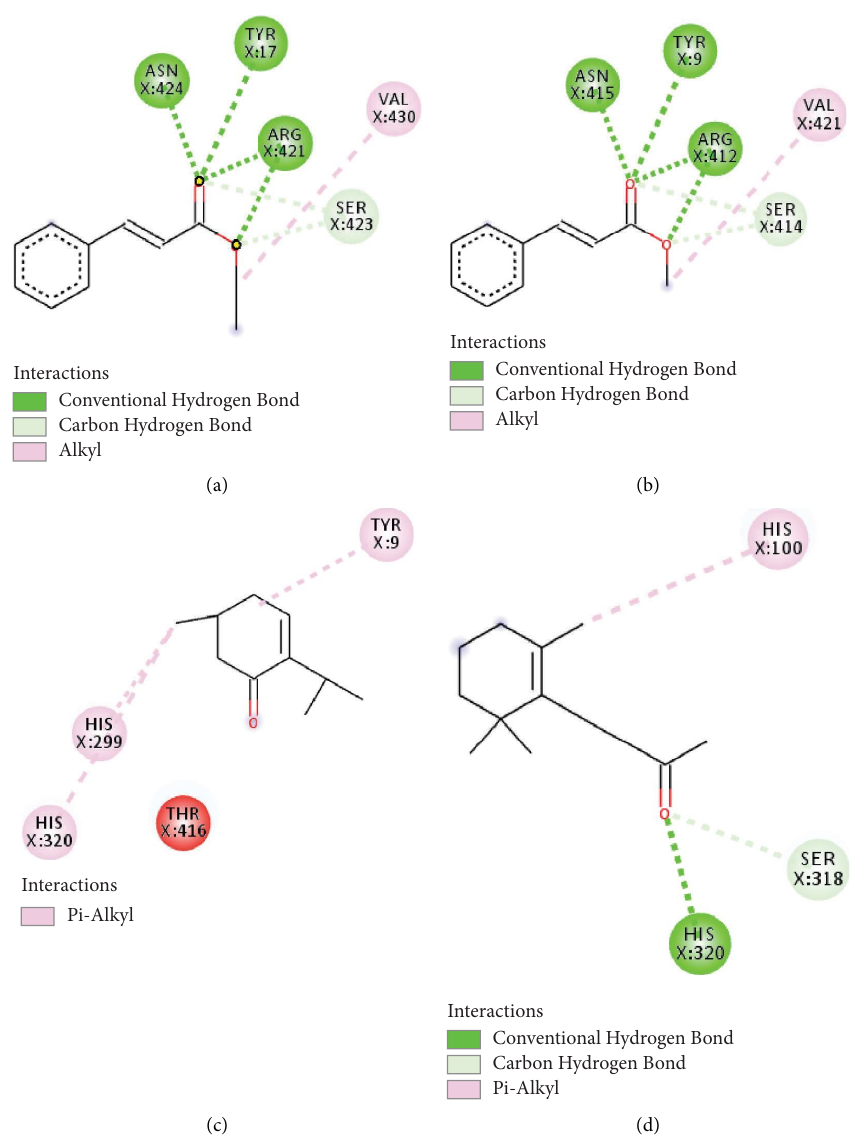
Figure 6: Molecular docking results: 2D view of interactions between compounds and the algC enzyme, (a) ethyl cinnamate, (b) methyl cinnamate, (c) p-menth-4-en-3-one, and (d) trans- α